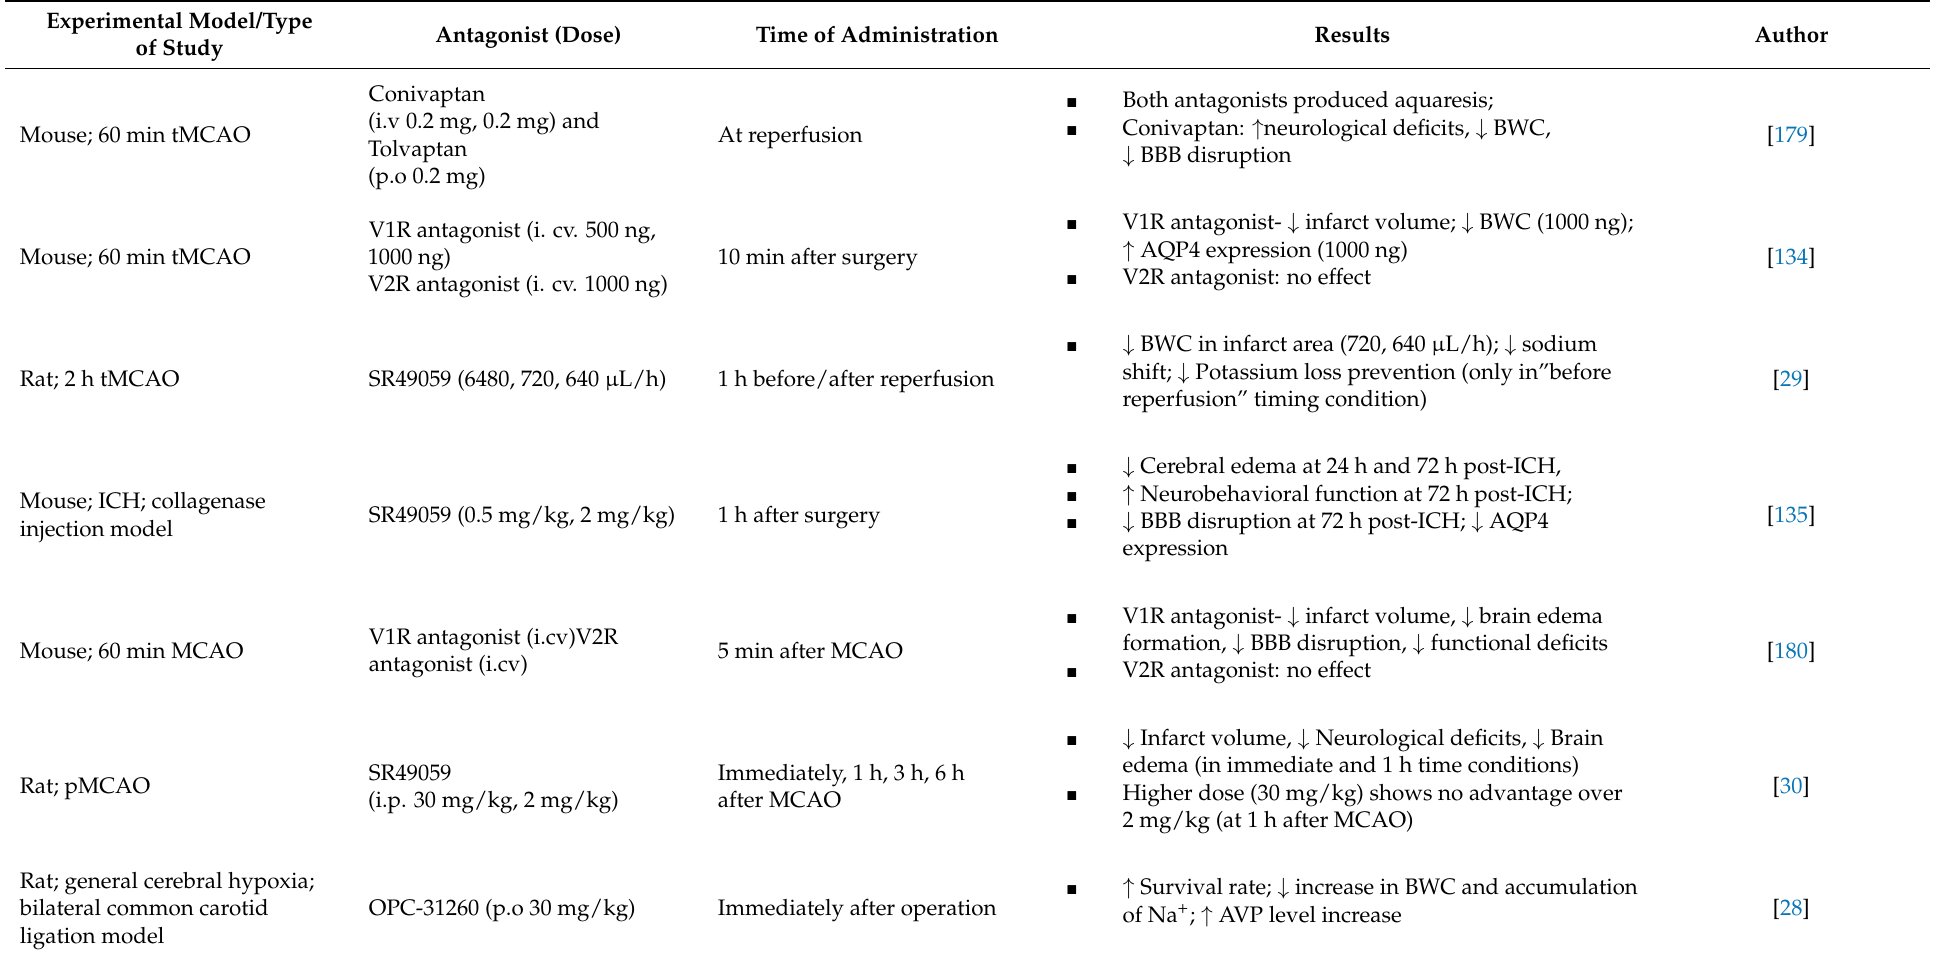
Table 2. The main results of selective and non-selective vaptans administration in animal and human stroke